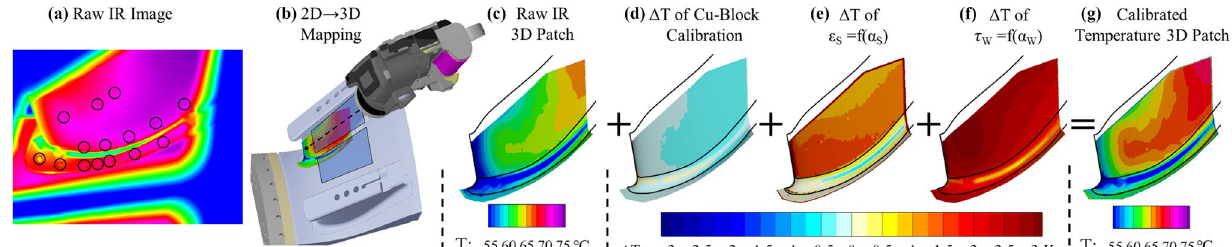
Fig. 4 Temperature postprocessing: from raw IR image to one calibrated temperature 3D patch